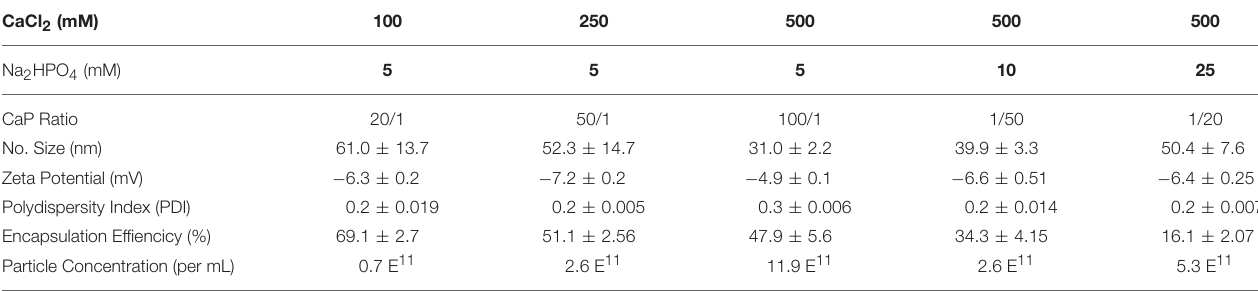
TABLE 1 | Particle size, Zeta ( ζ )-potential, polydispersity index, and encapsulation effiency of SOD1 antisense oligonucleotide calcium phosphate-lipid nanoparticles (SOD1-ASO CaP-lipid NPs) prepared at different CaCl 2, and Na 2 HPO 4